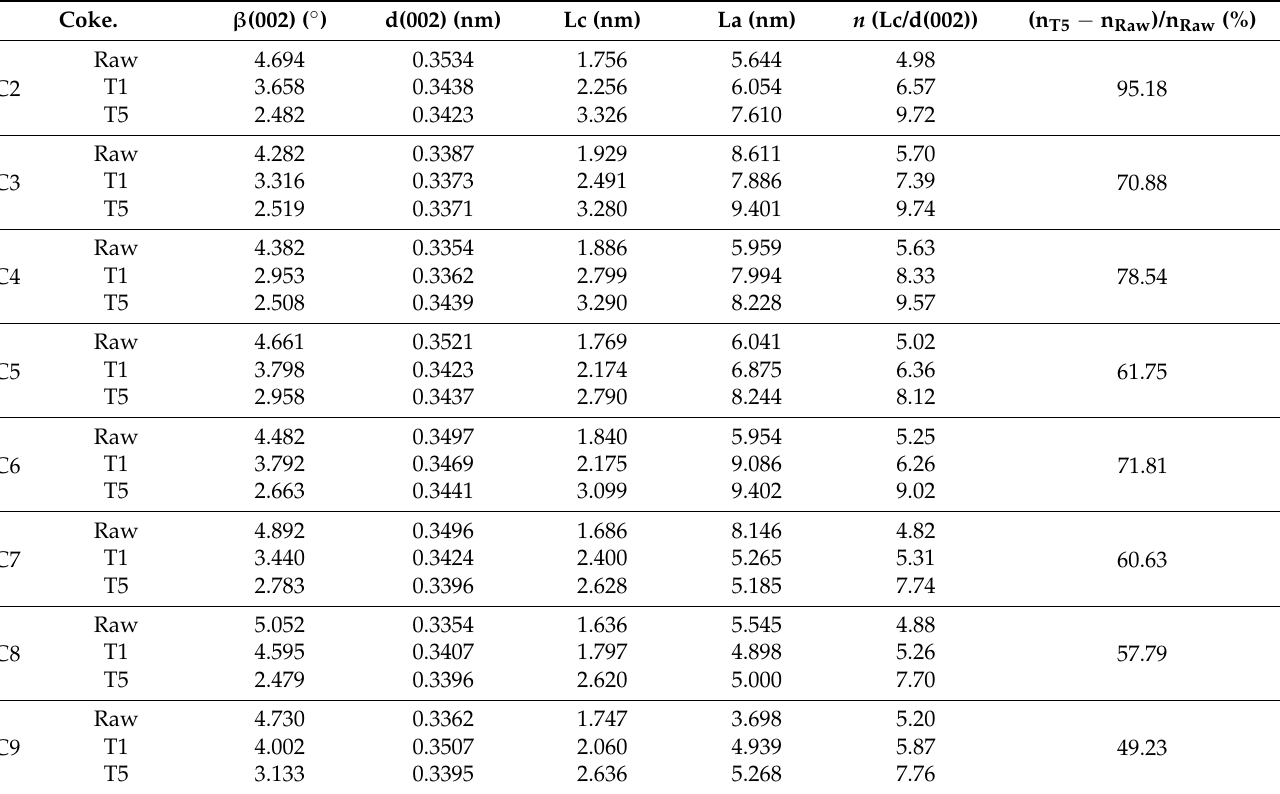
Table 4. The carbon crystal structure parameters of